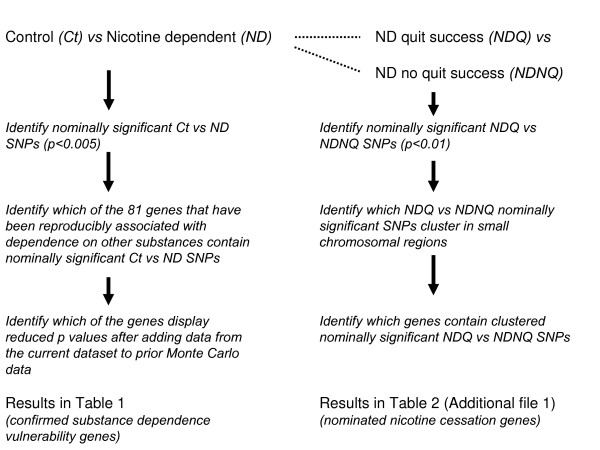
Diagram outlining the analyses undertaken in this report. (left) Comparisons between allele frequency assessments at 520,000 genomic SNPs in the whole group of European American nicotine dependent subjects who volunteered for inclusion in nicotine cessation trials in comparison to SNP frequency assessments for European-American control research volunteers without histories of any substantial use of any addictive substance. The preplanned analysis of this data focused on the extent to which these nominally positive SNPs added to the significance of the results of previously assembled convergent data from studies of other four other addict vs control comparisons. Genes for which the Monte Carlo significance increases (eg lower p values) after adding the current data to previously-obtained data are listed in Table 1. (right) Comparisons between allele frequency assessments at 520,000 genomic SNPs in two subgroups of the European American nicotine dependent research participants who volunteered for inclusion in nicotine cessation trials, described previously. NDQ subjects successfully abstained from smoking for at least 6 weeks after completion of therapeutic trials using nicotine and/or mecamylamine, NDNQ subjects did not abstain for this period. The preplanned analysis of this data focused on the extent to which the nominally-positive SNPs from this comparison clustered together in genomic regions that encoded genes in comparison to chance levels, assuming independence of SNP allelic frequencies. Genes that contain at least three nominally positive SNPs and are thus nominees to contain variants that participate in the genetic underpinnings of individual differences in smoking quit success are listed in [see additional file 1].